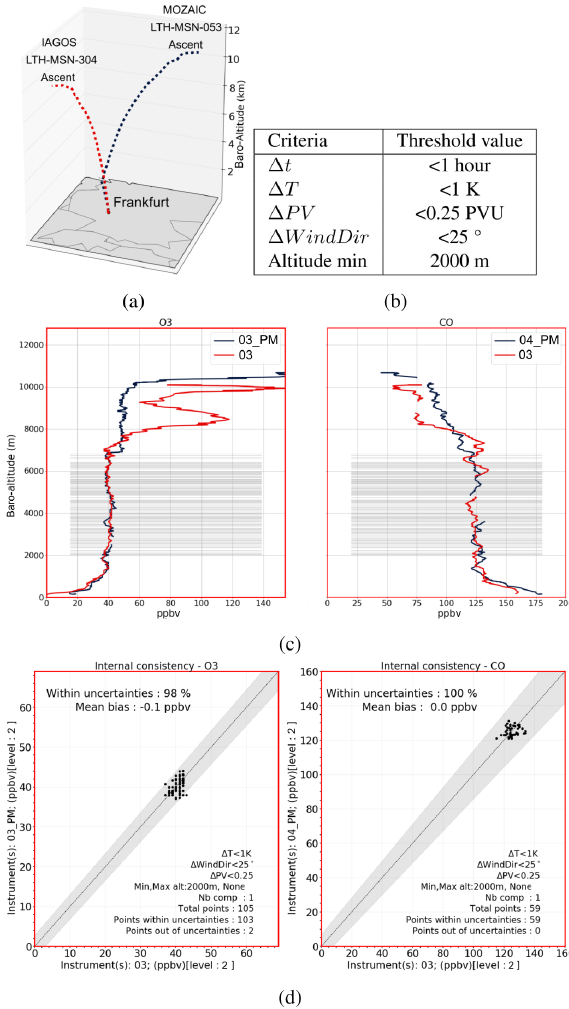
Figure 9. Percentage of points within the uncertainty and mean bias as function of the potential temperature difference measured by the co-located aircraft found for CO instrument 04 PM and for FP no. 13 on Lufthansa A340msn53. The total number of comparable points according the air temperature difference is also shown. The maxi- mum time difference between the landings or the takeoffs is